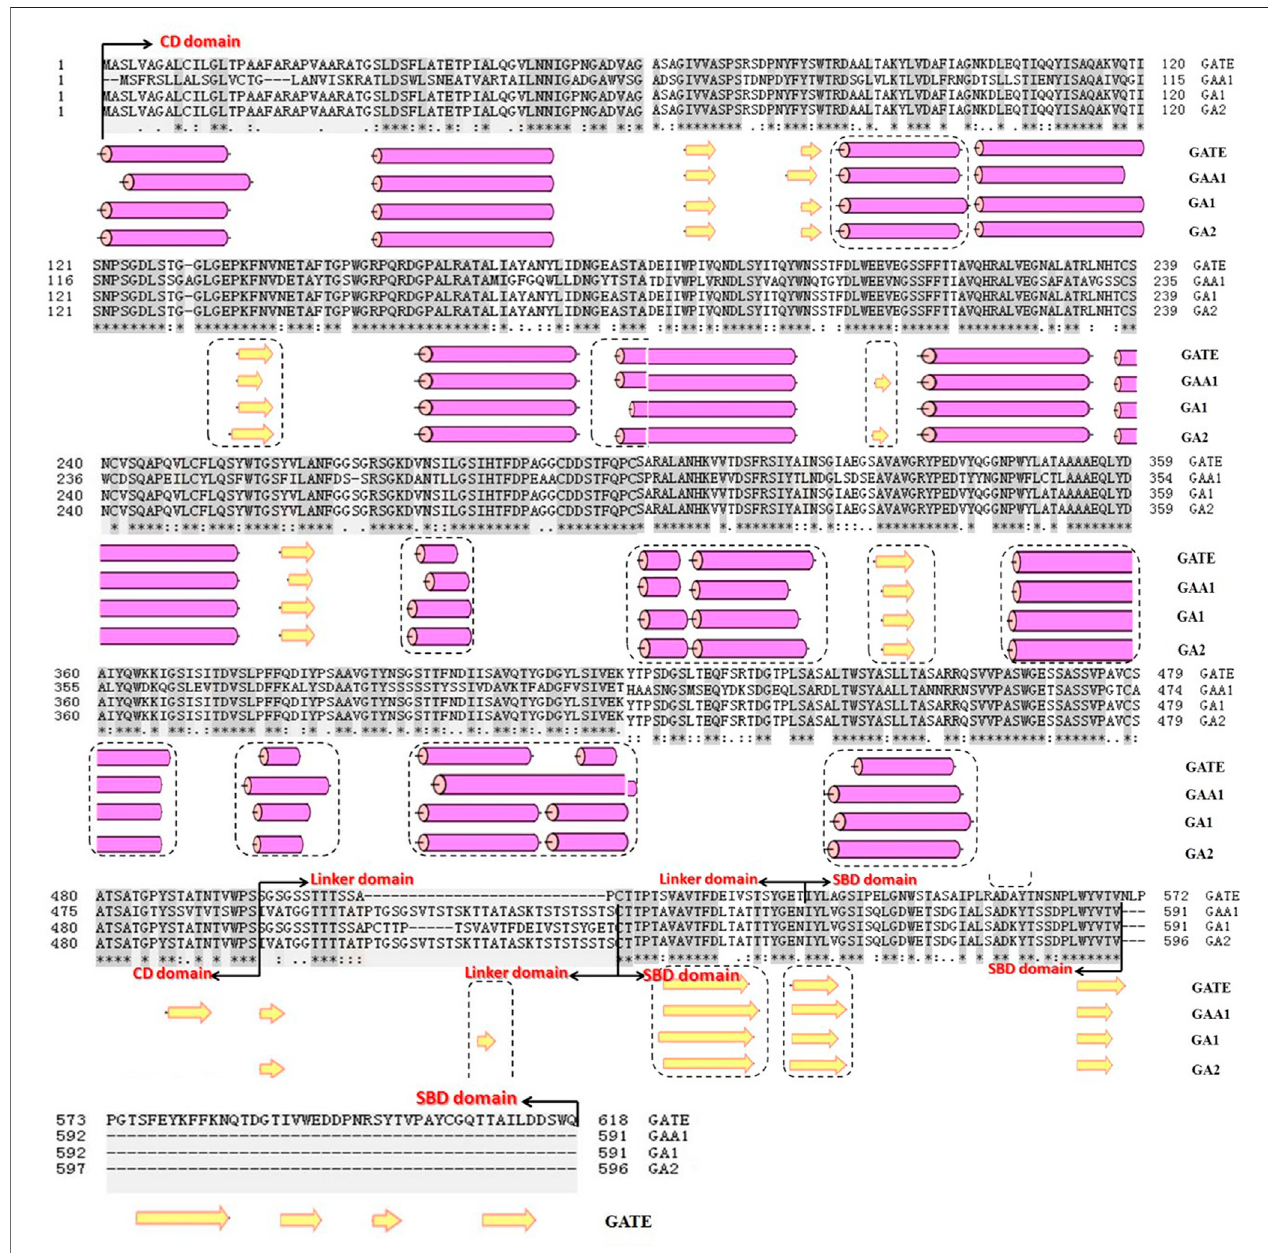
FIGURE5| PredictionandcomparisonofsecondarystructuresofGA1,GA2,GATE,andGAA1usingthetoolPSIPRED.Theyellowarrowmeans β -sheet,andthe circular column means α -helix.